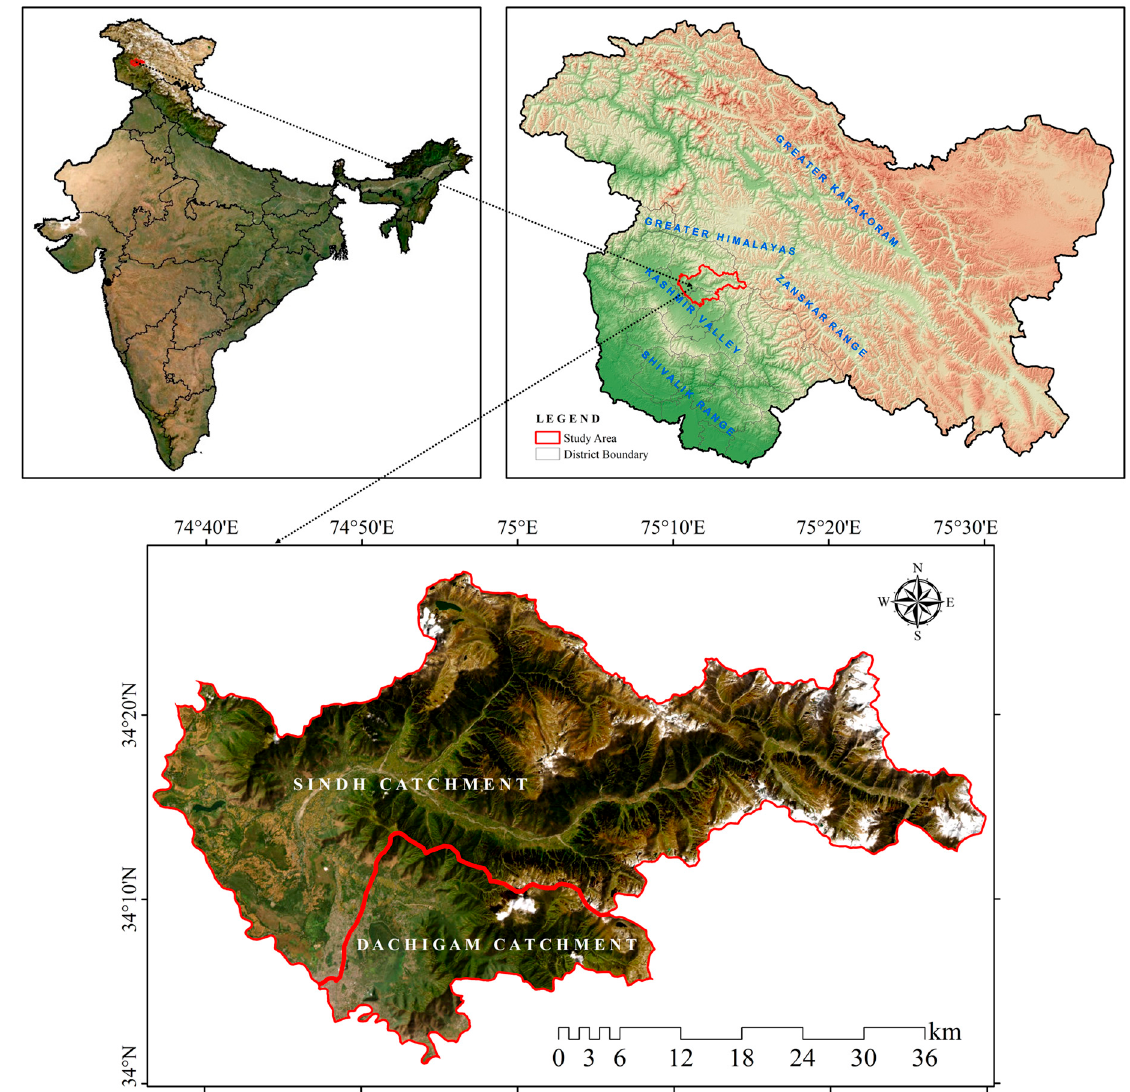
Figure 1. Location map of the Central Kashmir region.